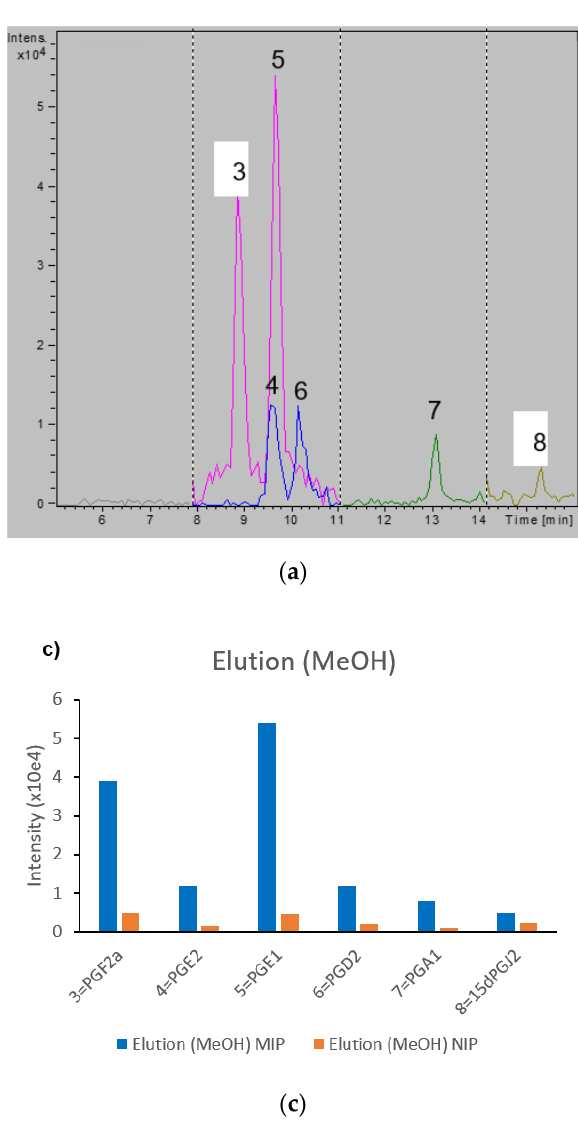
Figure 3. Chromatogram of reconstituted Elution fractions (MeOH) from the experiment in Figure S6. MIP elution fraction ( a ), NIP elution fraction ( b ), and corresponding peak intensities of key PGs ( c ). Numbering of PG peaks as in Figure 2. Colors indicate the different MRM transitions monitored.